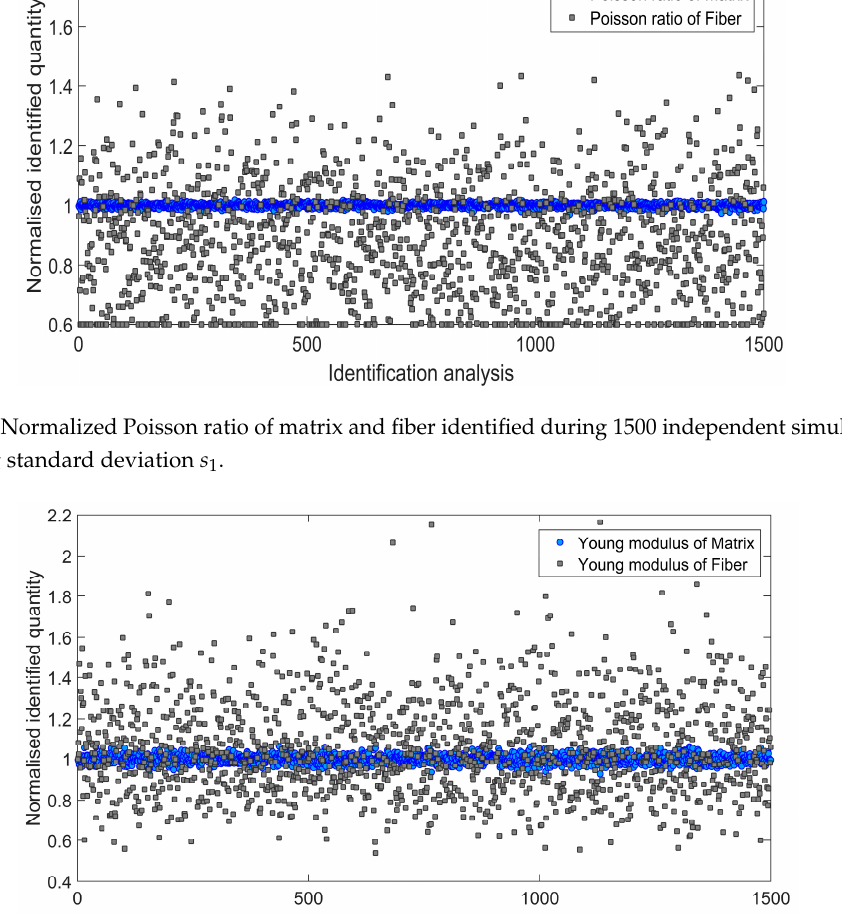
Figure 8. Normalized Young modulus of matrix and fiber identified during 1500 independent simulations involving standard deviation s 2 .